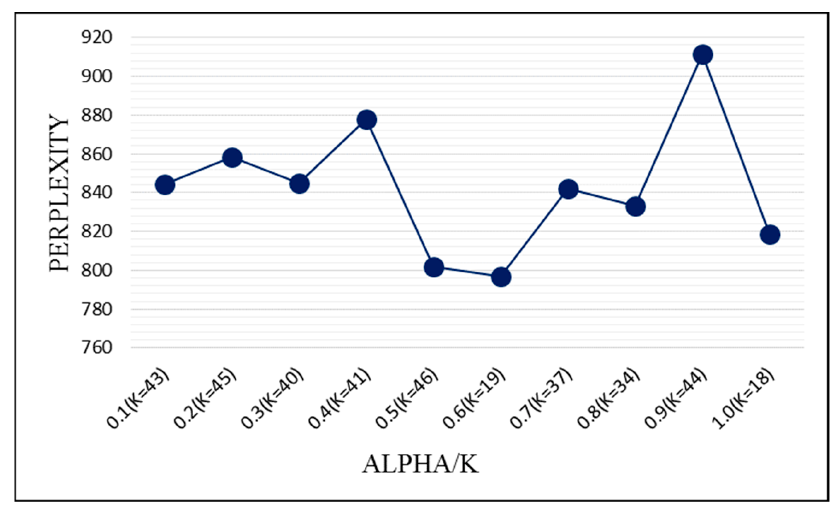
Figure 5. Perplexity with different values of α and k .